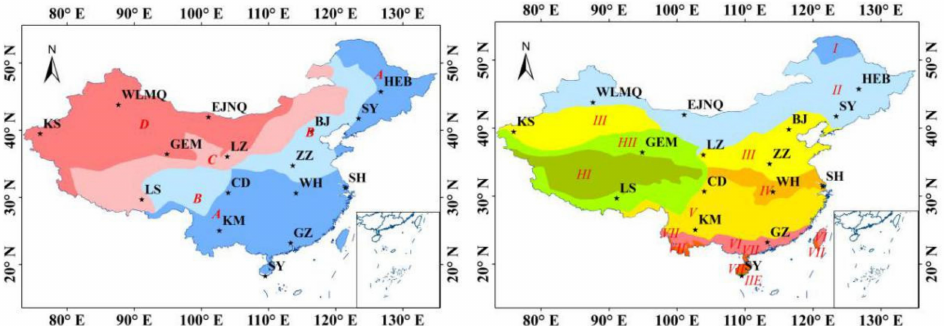
Figure 1. Geographical locations of the R s stations in the different humidity zones ( left ) and temper- ature zones ( right ) of China (A for humid, B for semihumid, C for semiarid, D for arid; I for cold temperate, II for midtemperate, III for warm temperate, IV for north subtropical zone, V for the midsubtropics, VI for the south subtropics, VII for the edge of tropical zone, HI for plateau subfrigid zone, HII for plateau temperate zone, and IIE for midtropical zone with humid weather).